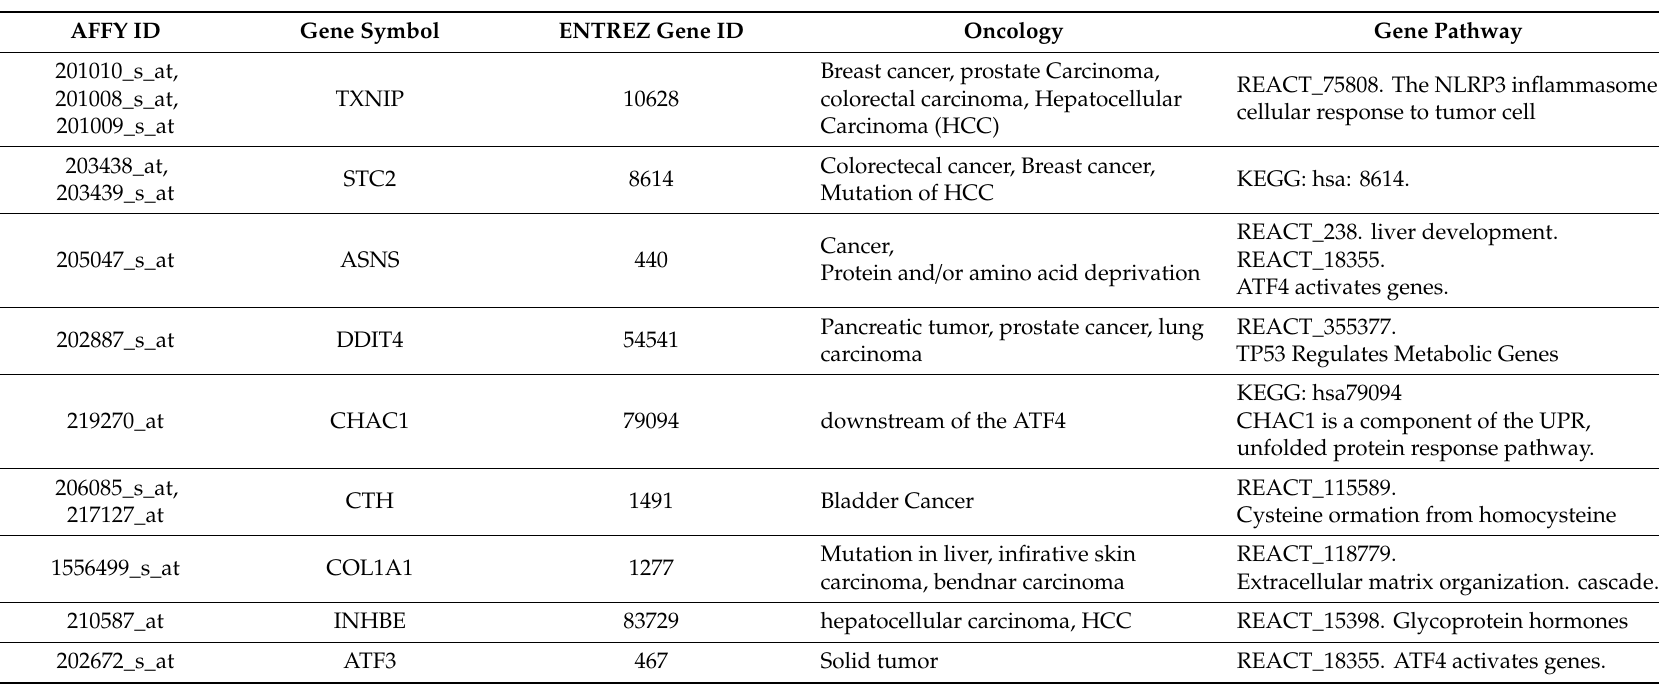
Table 1. Functional annotation of key genes detected using T -test, and F-test methods after di ff erent periods of post-infection with C